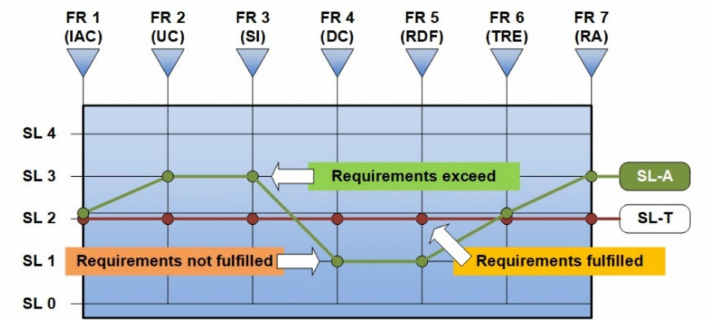
Figure 11. SL-T to SL-A relationship graph diagram.